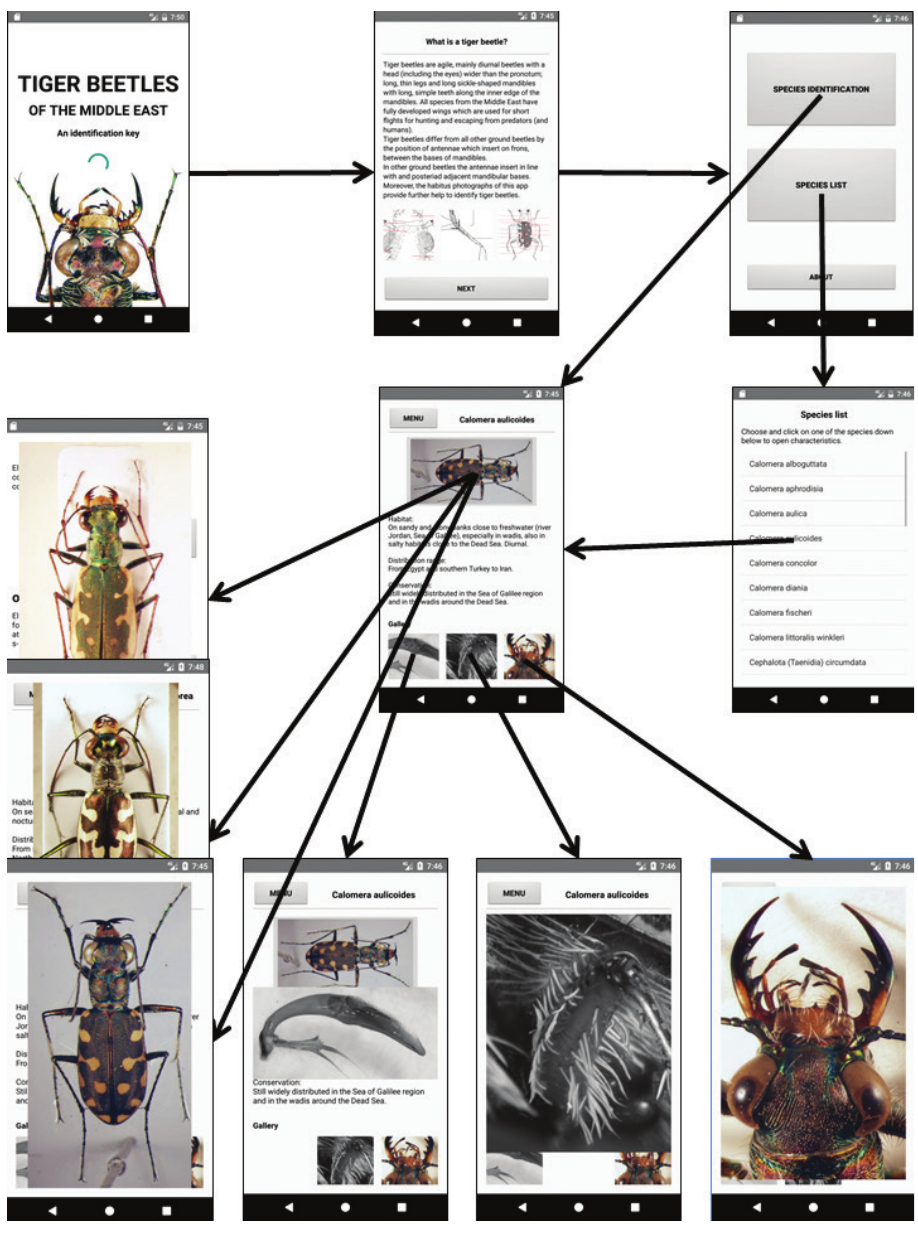
Figure 56. Overview of the main functions of the application TIGER BEETLES ID. This stand-alone application for mobile Android devices (smartphones, tablets) can be freely downloaded at https://doi.